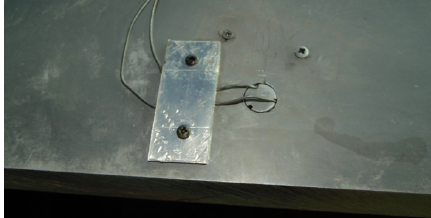
Figure 11. Positioning of the thermocouples dur- ing the quenching tests.